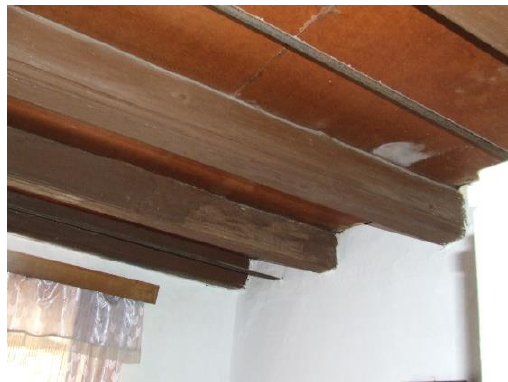
Figure 23. Posttensioning of the building was done using steel Φ20 mm rods. Figure 23. At their ends, the rods were anchored to the 10 mm thick steel plates.